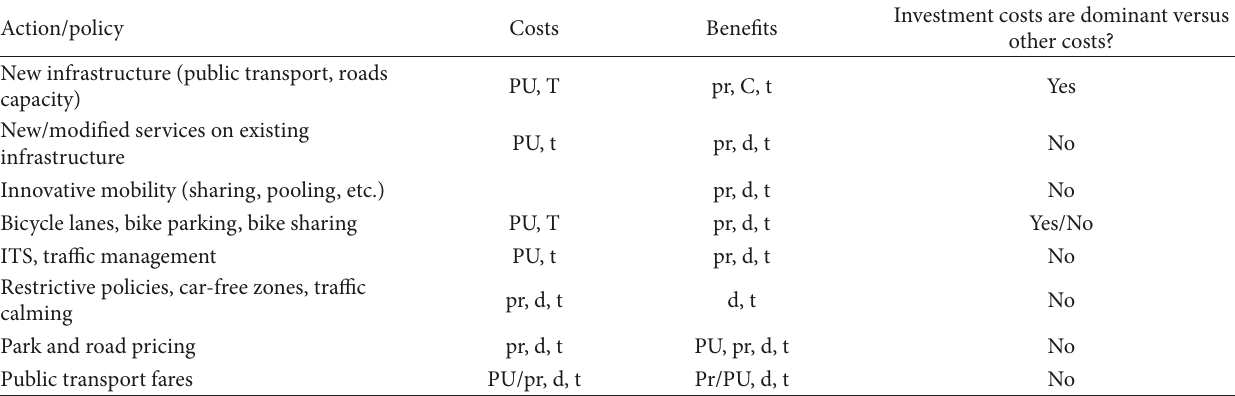
Table 1: Policy actions in a mobility plan and type of